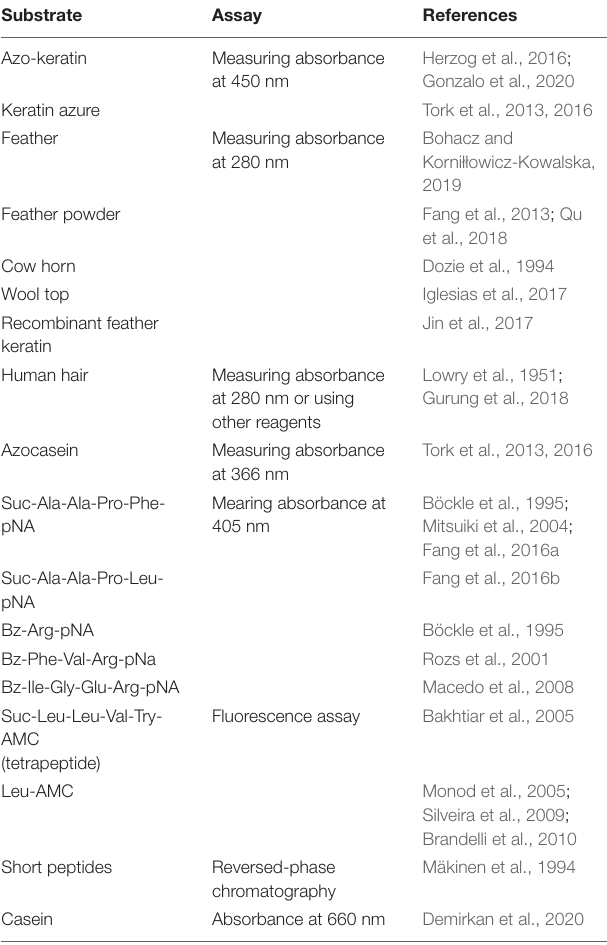
TABLE 2 | Substrates used for analyzing keratinase